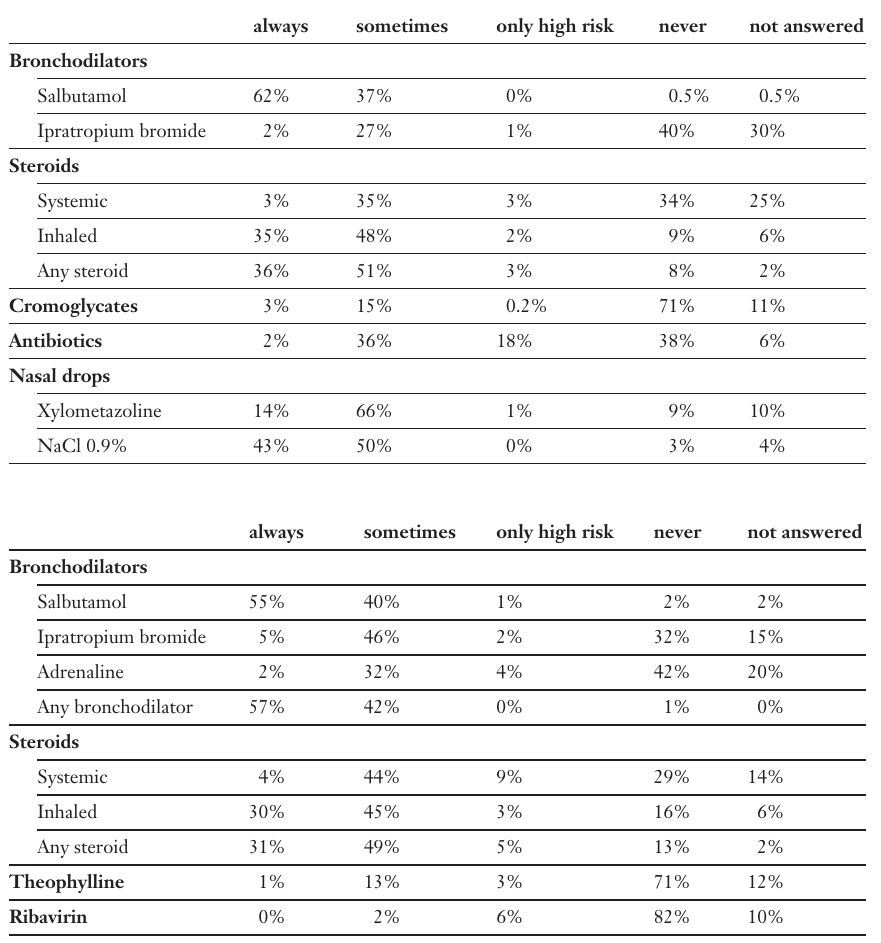
Outpatient management.